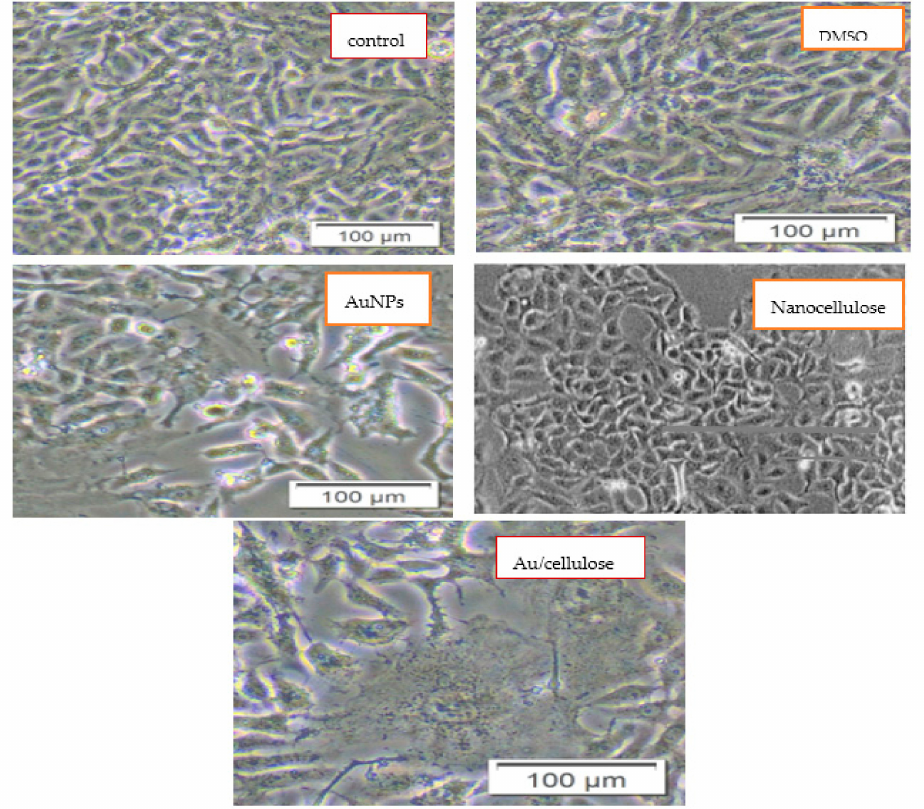
Figure 5. Representative cell images reveal the cell viability of A549 cells that were pre-treated with 100 µ g/mL AuNPs, nanocellulose, and Au/cellulose nanocomposite in comparison with DMSO- treated cells and control